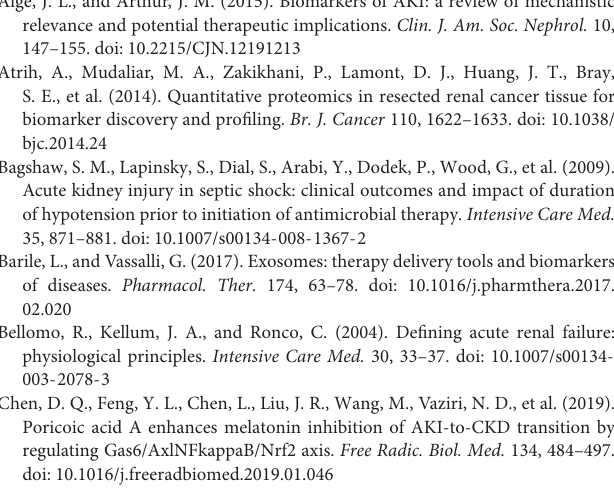
TABLE S2 | One-way ANOVA was performed to analyze the differential expression protein in the urine after sepsis-induced AKI. P < 0.05. TABLE S3 | The continuous changing protein in the urine after sepsis-induced AKI. P <